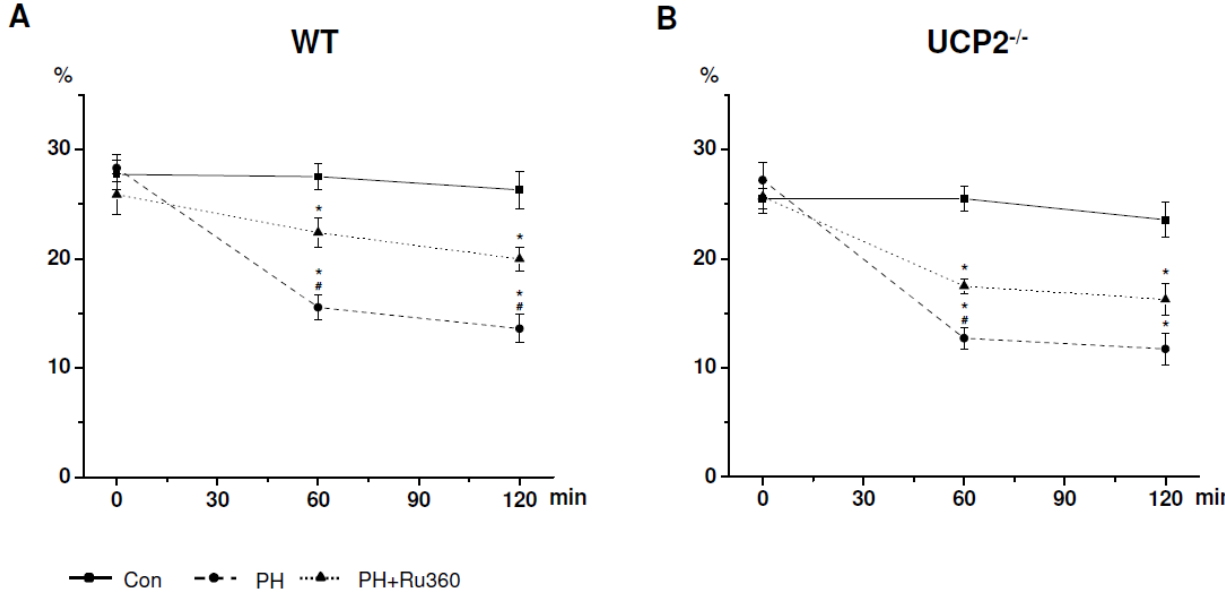
Figure 1. Total cell viability after 0, 60 and 120 min ( A ) in WT and ( B ) in UCP2 −/− cardiomyocytes. Con = cells stored in control solution; PH = pelleting hypoxia alone; PH+Ru360 = pelleting hypoxia previously incubated with Ru360 (10 µM); * p < 0.05 vs. Con; # p < 0.05 vs.